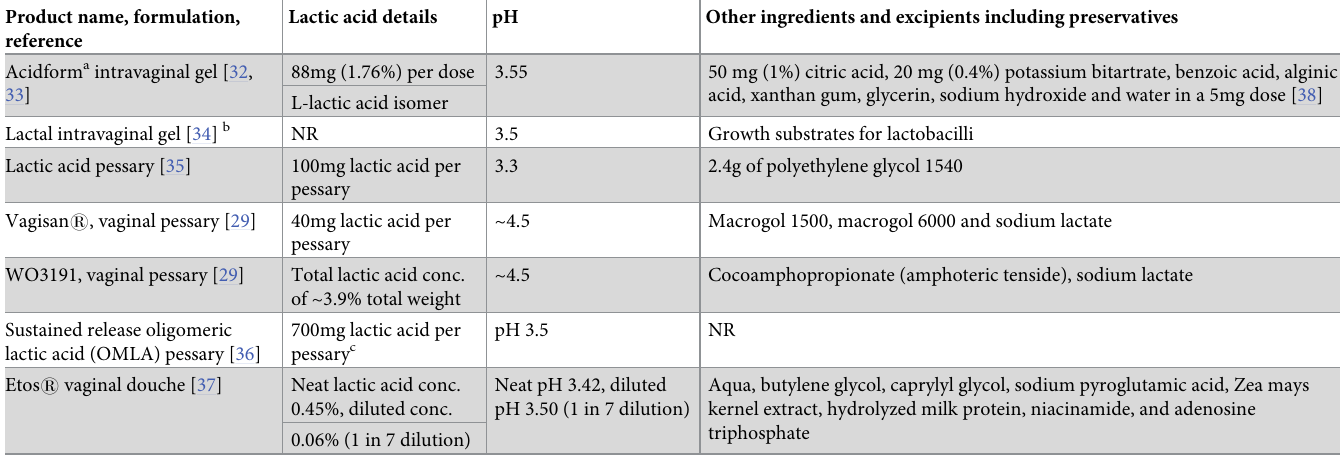
Table 1. Lactic acid-containing product details. Product name, formulation,